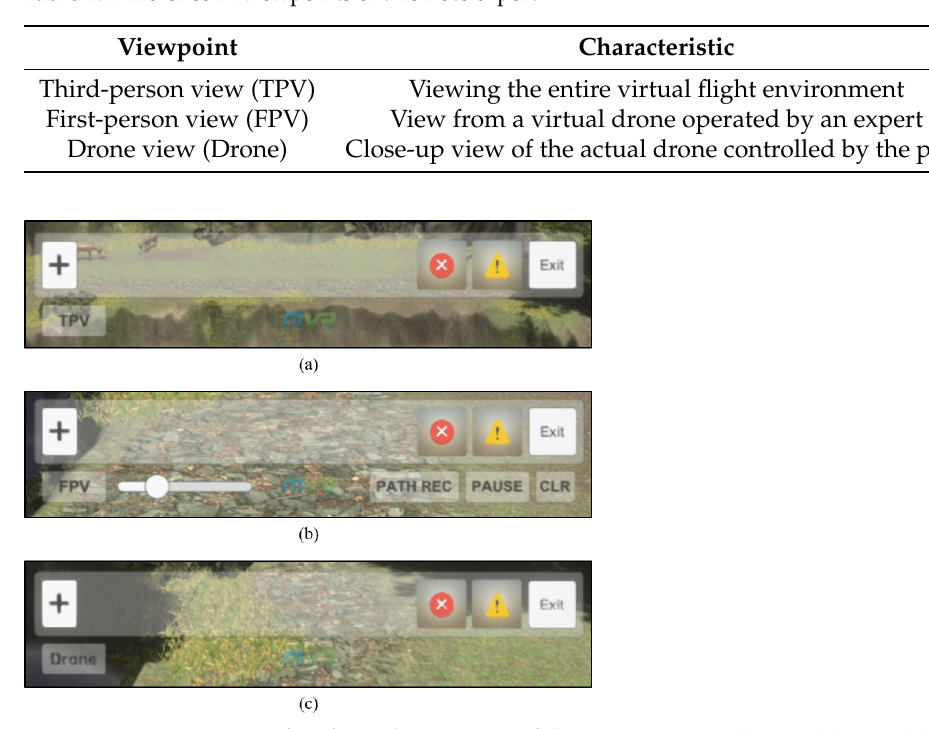
Figure 10. ex-STnAD interface for each viewpoint of the remote expert: ( a ) TPV; ( b ) FPV; ( c ) drone.